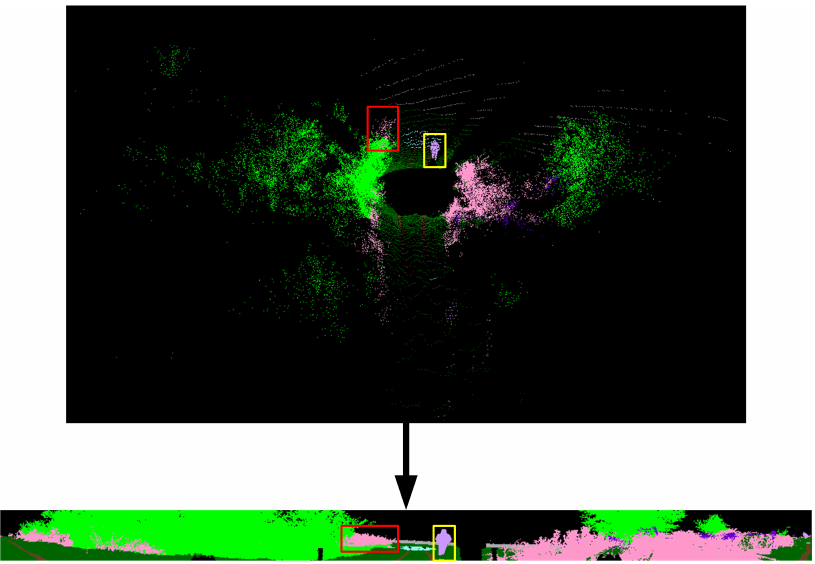
Figure 2. An illustration of the point cloud segment transformed to range image. Red point is center and gray points are neighbor points.